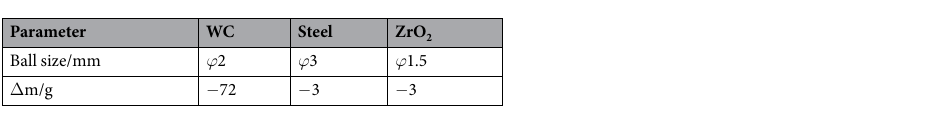
Table 2. Weight loss of different ball SMATed WL10 samples. “ − ” reference the SMATed sample mass